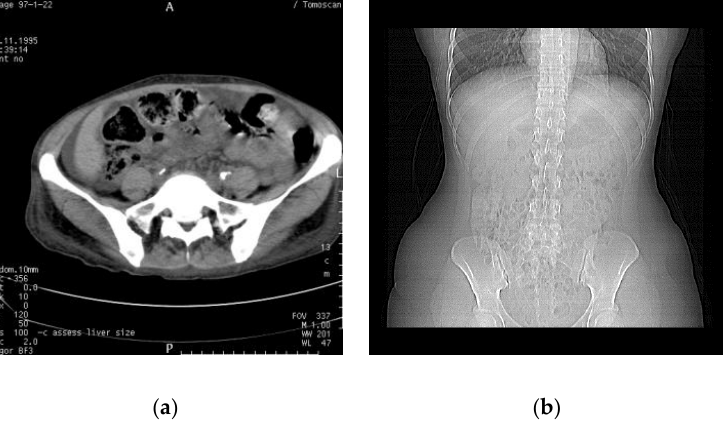
Figure 4. Medical images used in the experiment. ( a ) Computed tomography (CT) and ( b ) X-ray.